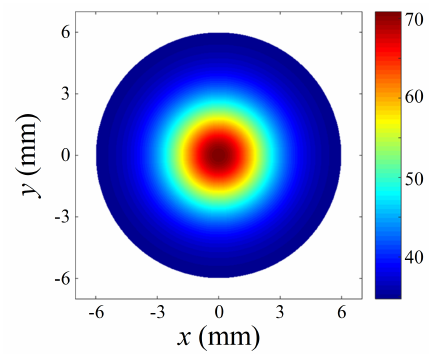
Figure 3. Temperature distribution across the surface beneath the THz beam (beam radius w 0 = 3mm, power density P d = 0.6W/cm 2 , and exposure time 1200 s).